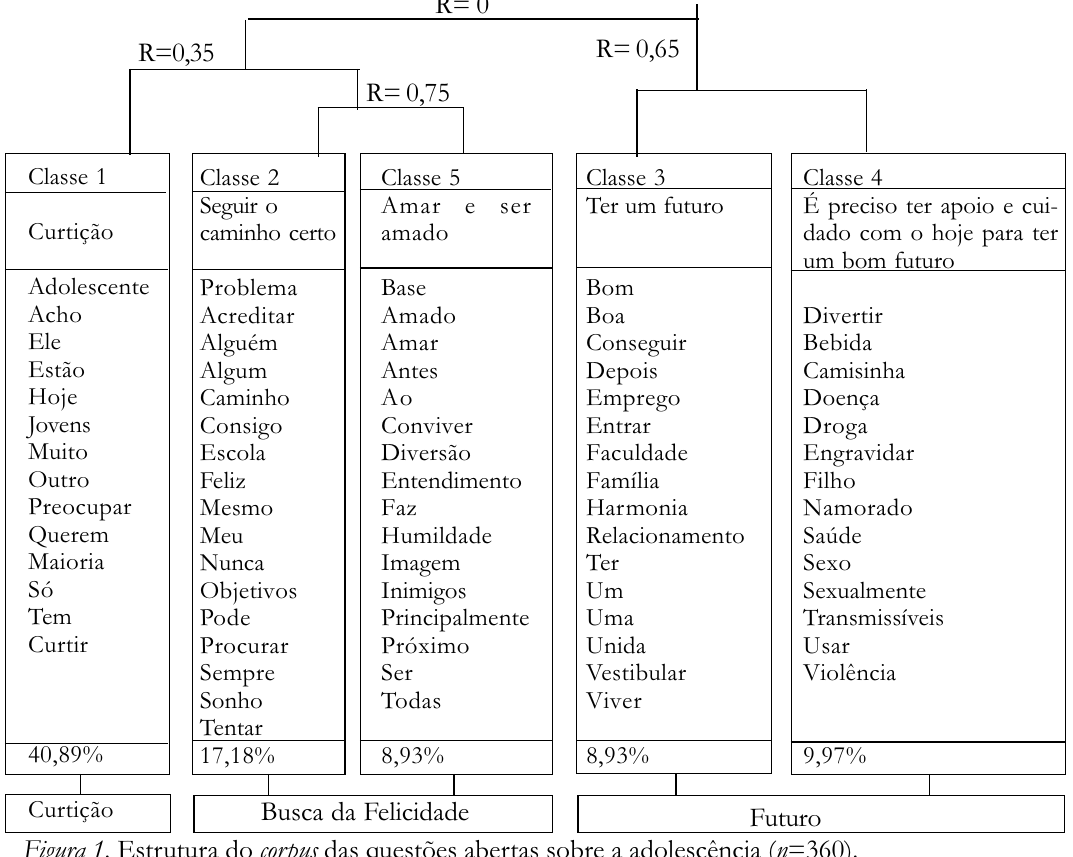
Figura 1. Estrutura do corpus das questıes abertas sobre a adolescŒncia ( n